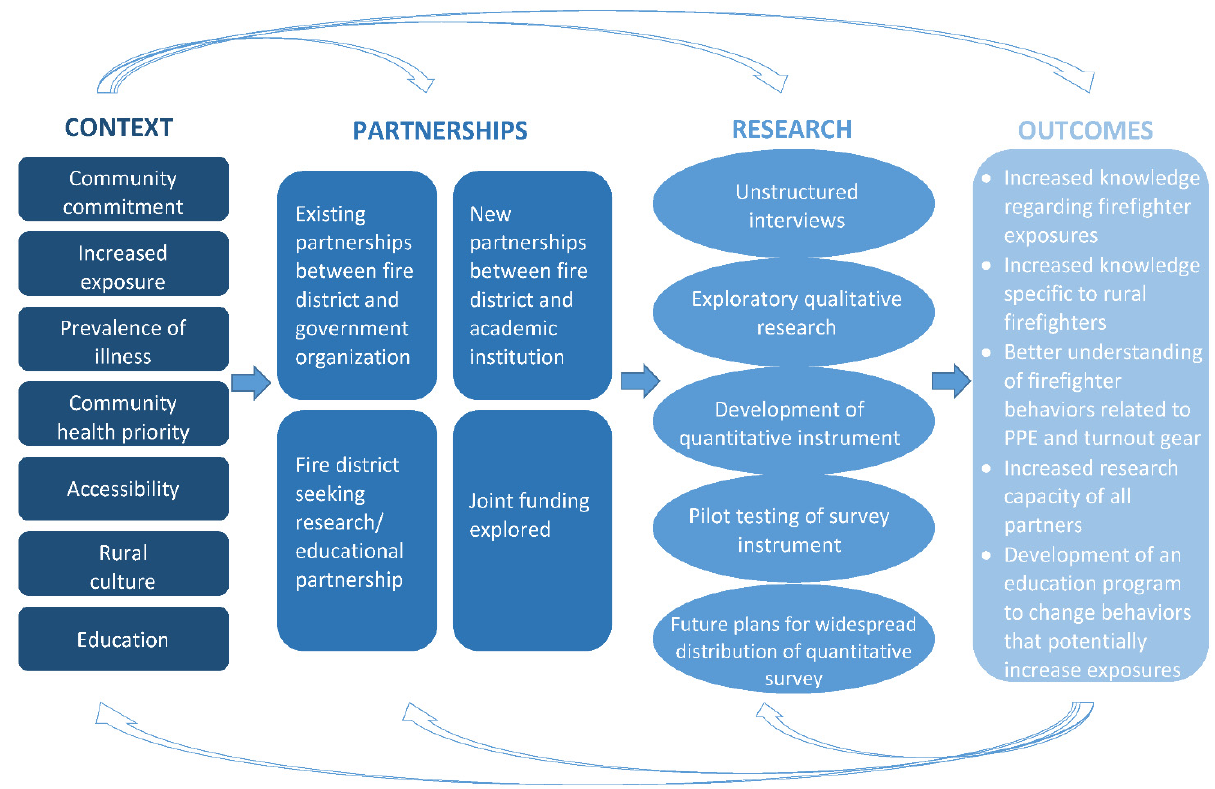
Figure 1. Conceptual Model of CBPR with Rural Firefighters. Adapted from Wallerstein et al. (2010) [17].